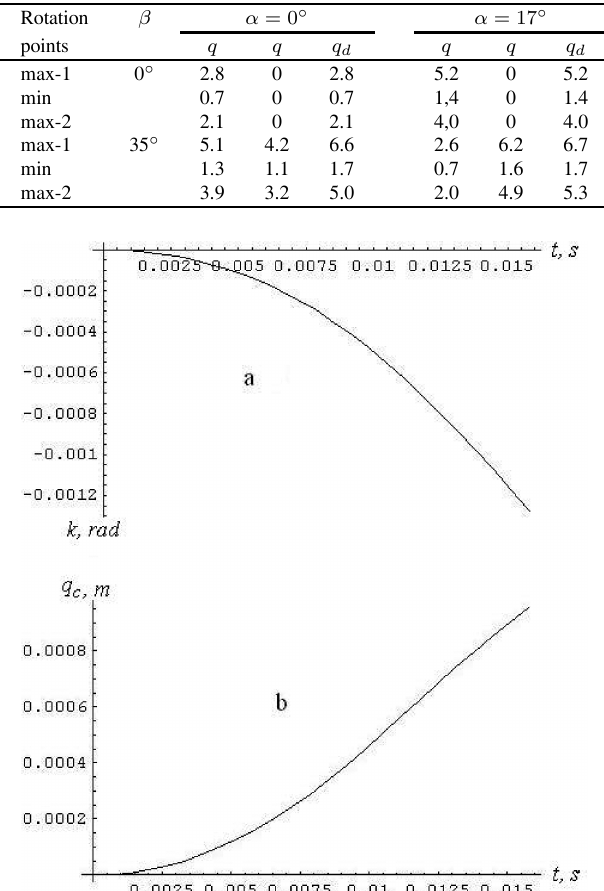
Table 2 Module displacements of the free ends of a stabilizer side rod (m − 6 )